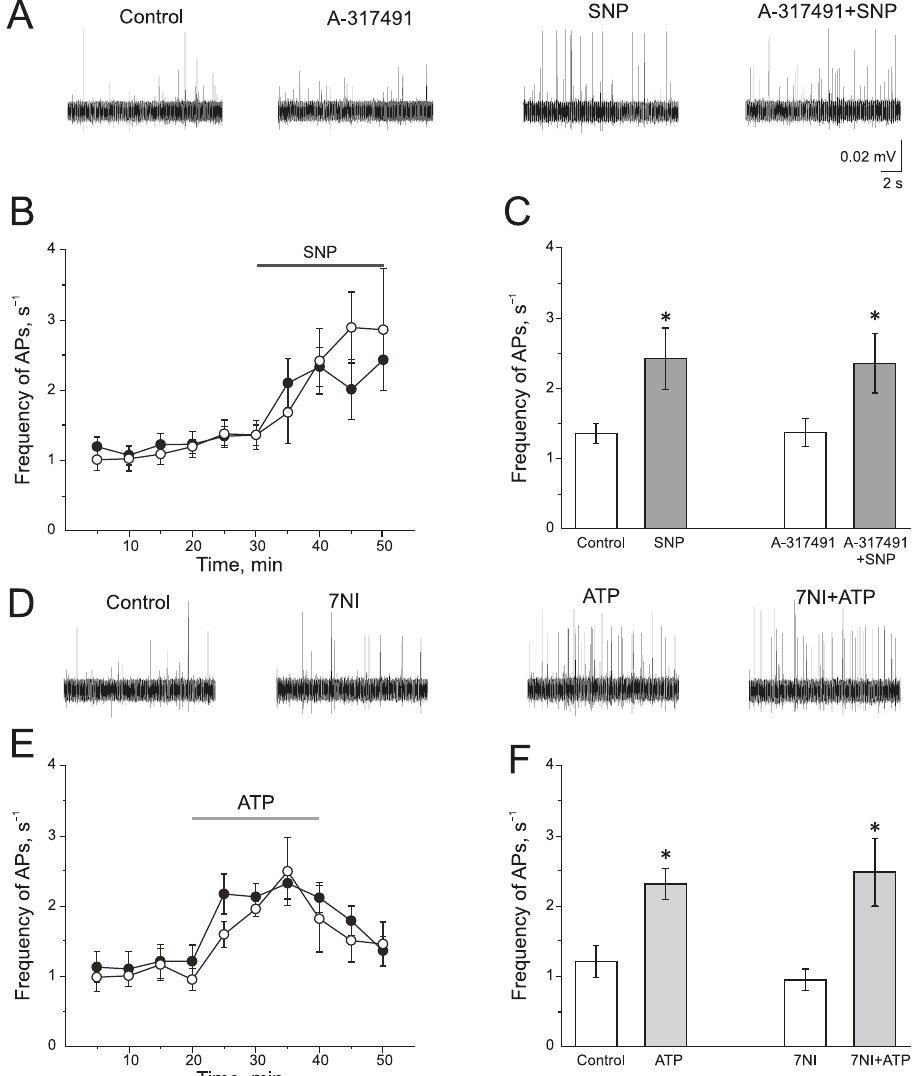
Figure 4. Interaction of NO and P2X3 receptors in rat trigeminal afferents ( A ) Sample traces of AP in the trigeminal nerve in the control or after the inhibition of P2X3 receptors by A-317491 (10 µ M), after the application of the NO donor—SNP (200 µ M) and A-317491 + SNP; ( B ) The time-course of AP frequency after the application of SNP in control (black circles) and after the inhibition of P2X3 receptors by A-317491 (white circles). ( C ) Histogram showing the maximum frequency of AP per 5 min in the trigeminal nerve after the application of SNP and A-31749 + SNP. ( D ) Sample traces of AP in the control, after the application of 7NI, ATP and 7NI + ATP; ( E ) The time-course of AP frequency after the application of ATP in the control (black circles) and in the presence of 7NI (white circles); ( F ) Histogram showing the maximum frequency of AP per 5 min after the application of ATP in the control and in the presence of 7NI. Mean ± SEM. * p <